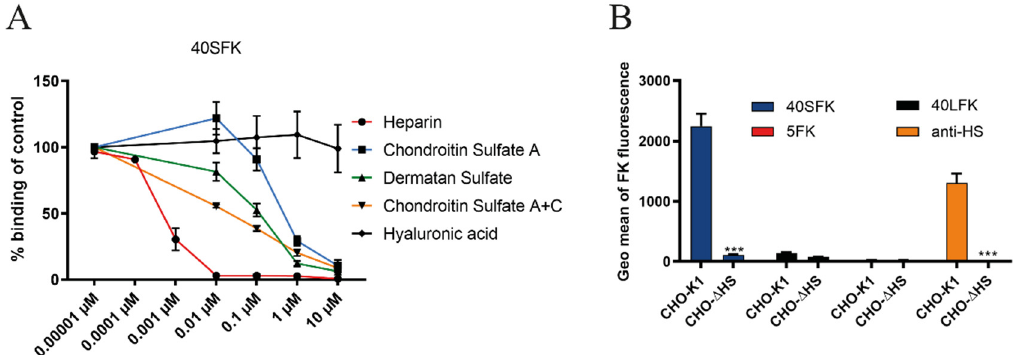
Figure 2. Effect of sulfation on FK binding: ( A ) 40SFK binding to A549 cells. Fiber knobs were pretreated with a broad range of concentrations of different glycosaminoglycans (GAGs). ( B ) Fiber knob binding to CHO cells expressing or lacking heparan sulfate (HS). HS expression levels are shown with an anti-HS antibody. The parental cell line CHO-K1 expresses GAGs and CHO- ∆ HS specifically lacks HS but expresses other GAGs. Binding was determined by geometric mean of fluorescence on a FACSLSRII flow cytometer and shown as % binding of fiber knobs on untreated cells in ( A ). All experiments were performed three times with duplicate samples in each experiment. Error bars represent mean ± SEM. Error bars represent mean ± SEM. *** P < 0.001 versus control.